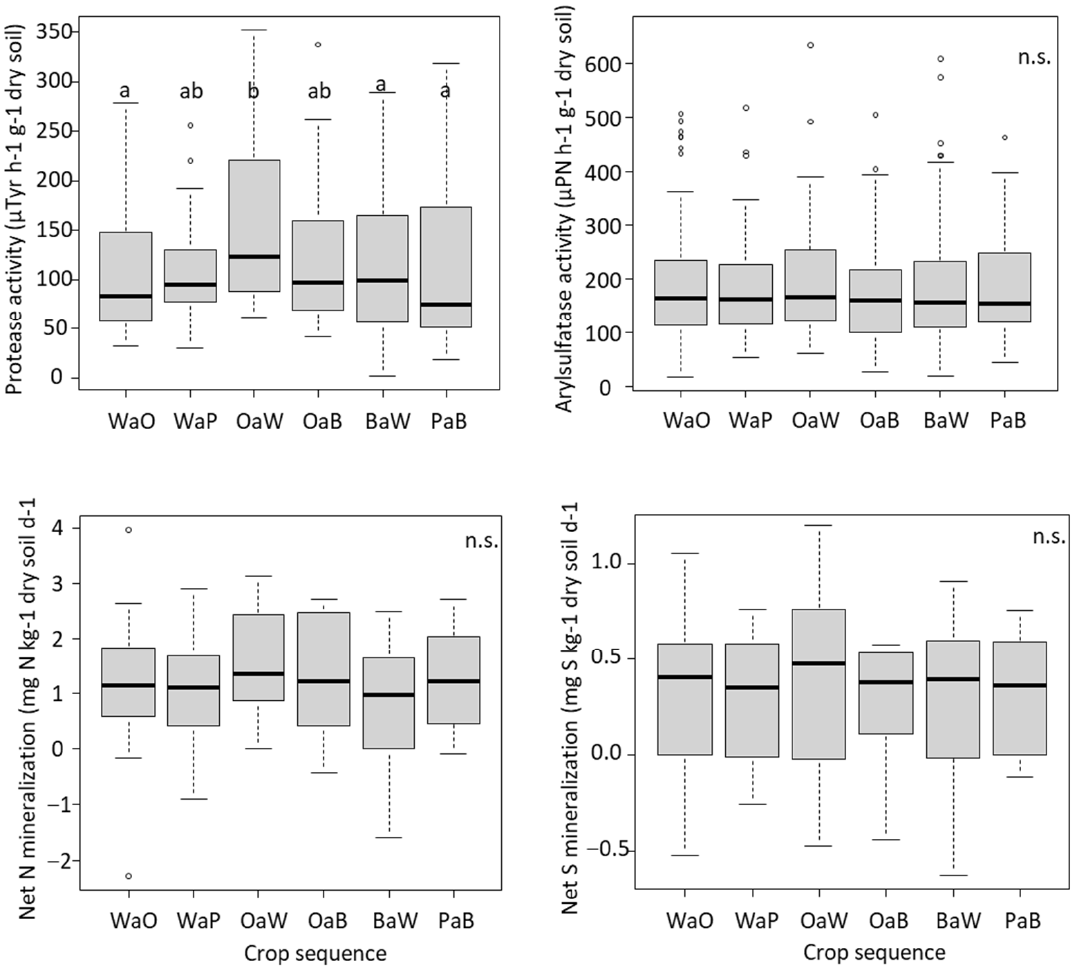
Figure 2. Enzymatic activities and net mineralization in soil under different crop sequences. Boxplots with different letters indicate significant differences between species ( p < 0.05, n.s.—not significant, Tukey post-hoc test). WaO, wheat after oilseed rape; WaP, wheat after pea; OaW, oilseed rape after wheat; OaB, oilseed rape after barley; BaW, barley after wheat; PaB, pea after barley. Table 1. F values from the two-way ANOVA with interaction, with crop sequence, year and month as factors. Bold indicates a significant effect. * p < 0.05; ** p < 0.01; *** p < 0.001. LM: linear model, GLM.nb: generalized linear model with negative binomial error distribution. Functional gene rela- tive abundance is expressed relative to the eubacterial abundance, and functional groups of cultura- ble bacteria are expressed relative to the total culturable eubacterial abundance.